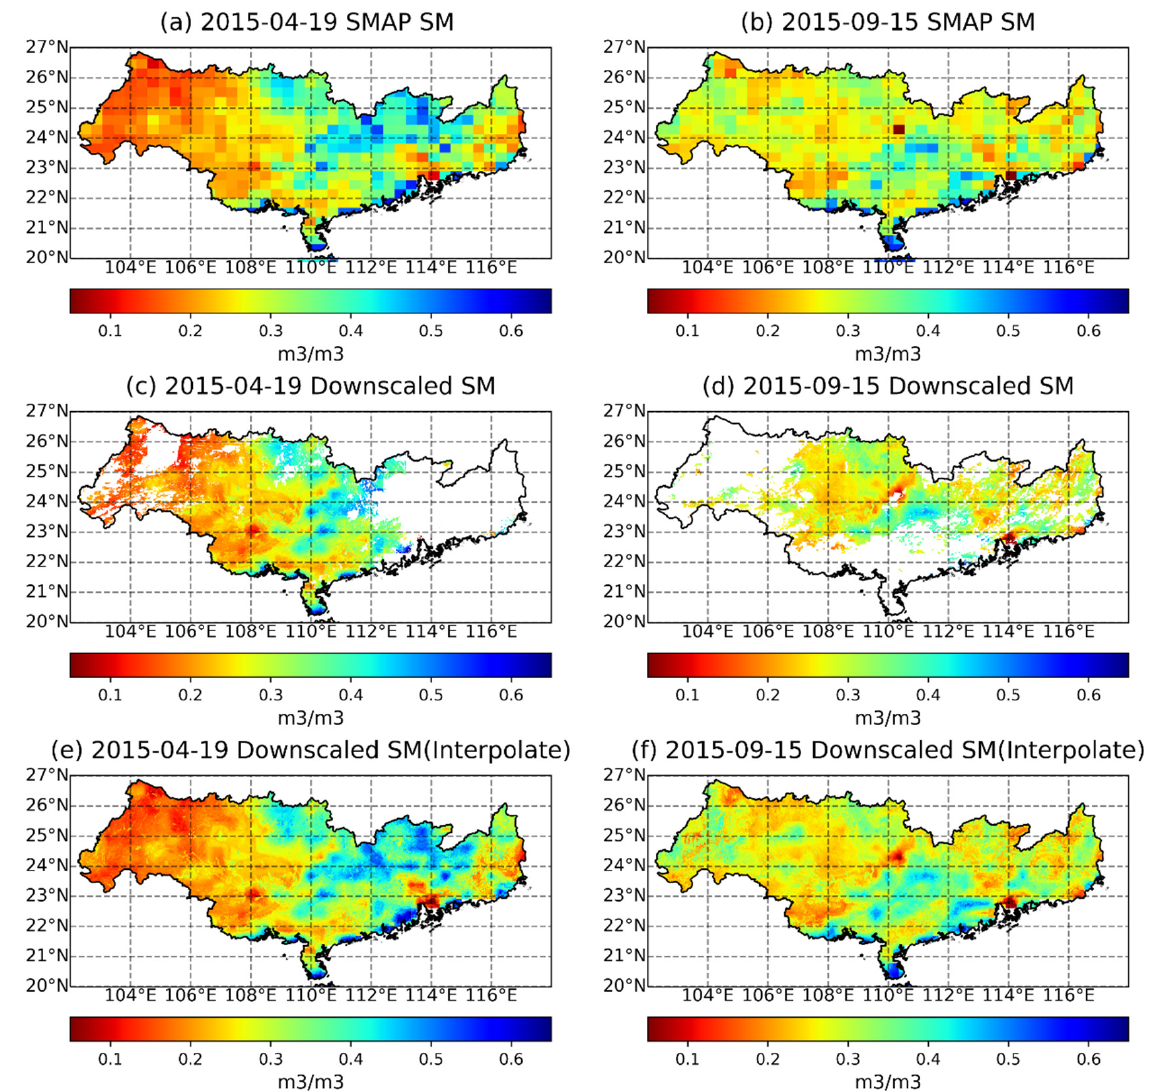
Figure 8. Distributions of the downscaled SM and original SMAP SM on 20 December 2017 and 28 November 2018 (cloudy).